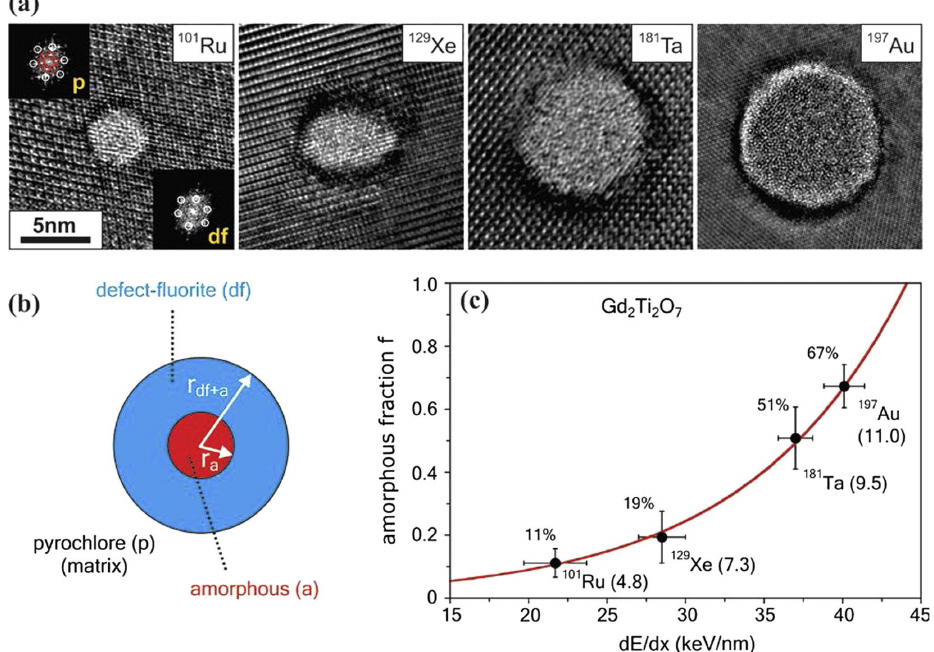
Figure 5. ( a ) High-resolution TEM images of individual tracks in Gd 2 Ti 2 O 7 pyrochlore produced by 1.1 GeV Ru ions (21.7 keV/nm), 1.4 GeV Xe ions (28.5 keV/nm), 2.0 GeV Ta ions (37.0 keV/nm), and 2.2 GeV Au ions (40.1 keV/nm). The track diameters increase systematically with dE / dx as shown from left to right. ( b ) Schematic of track morphology showing the amorphous core (red) surrounded by a defect-fluorite structured shell (blue) embedded in the pyrochlore matrix. Fast Fourier transform (FFT) analysis of TEM images confirm the crystalline phase of matrix (pyrochlore, p ) and track shells (defect-fluorite, df ), displayed in ( a ) for the Ru ion track. The loss of the spots in the inner circles corresponds to the loss of the long-range ordered pyrochlore superstructure leading to the defect-fluorite structure. ( c ) The amorphous fraction within an ion track (normalized core-to-shell ratio) increases significantly as a function of dE / dx . The error bars represent the dE / dx variation over the entire sample thickness and the uncertainties of determining the area of amorphous core and entire track, respectively. The values in % represent the amorphous fraction, and the numbers in parenthesis are the total track diameters in nm (core + shell). The scale bar applies to all TEM images. Reproduced with permission from Reference [135], Copyright © Elsevier 2014.